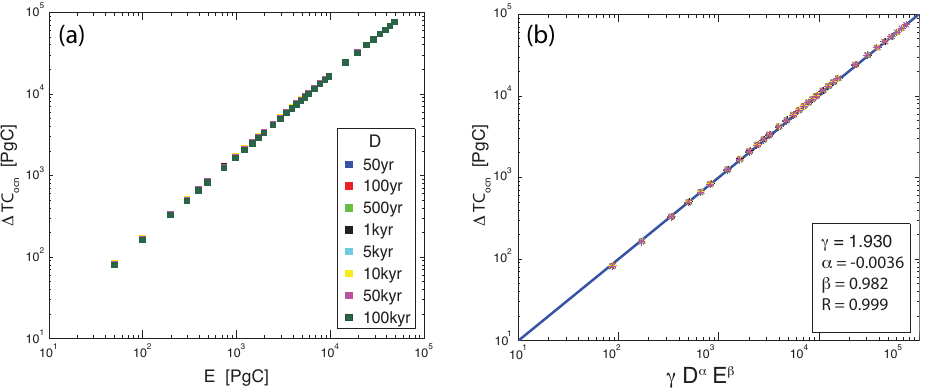
Figure 9. (a) Peak changes in the modern oceanic total carbon content as a function of total emission, E , for various durations, D . (b) Mul- tivariable regression results. Solid line indicates a perfect fit to the predicted scaling. The asterisks are each individual